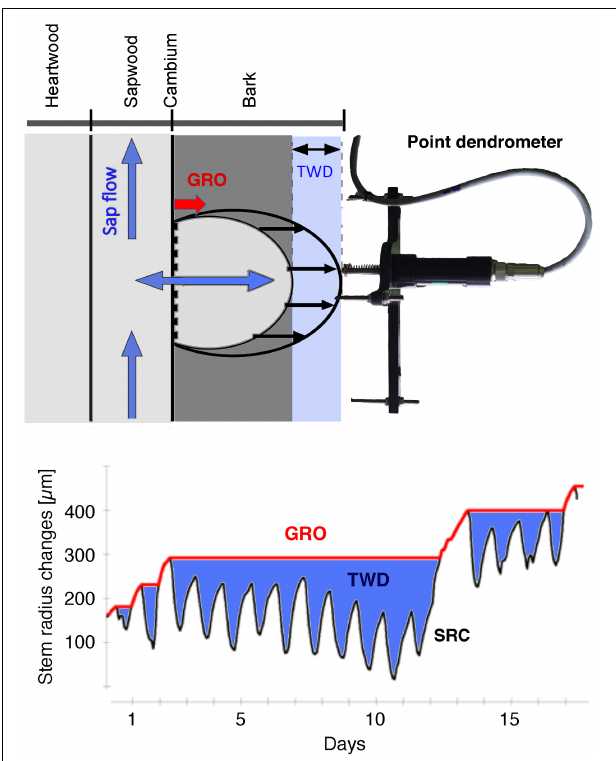
FIGURE 4 | Stem radius changes (SRC; including the bark) measured by a point dendrometer are separated into the fractions tree water deficit (TWD) and growth (GRO) according to the zero-growth concept. TWD is reversible and is induced by changes in plant water potentials. GRO is irreversible and consists of new built cells in the wood (xylem) and in the bark